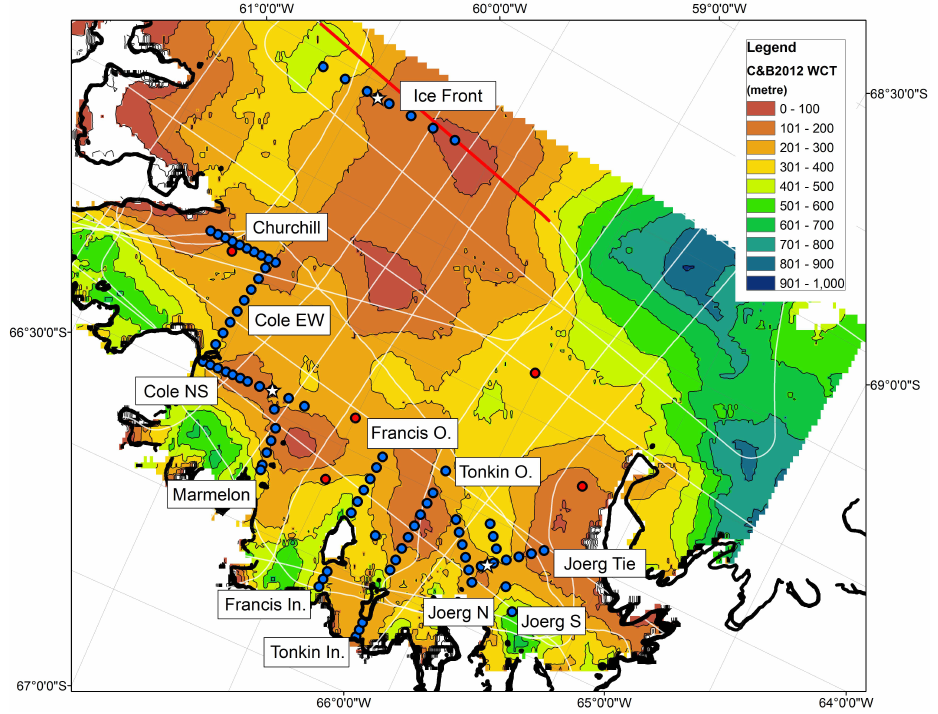
Fig. 2. Seismic reflection acquisition sites presented in Fig. 6 (blue circles) with line names as referred to in the text overlain on the contoured water cavity thickness derived from the inversion of IceBridge free-air gravity anomaly (Cochran and Bell, 2012). White stars indicate the three shallow seismic refraction sites where velocity-depth profiles were derived. Previous sites as per Fig. 1 (red circles). The grounding line as derived from DInSAR data (Rignot et al., 2011) is represented by the thick black coastline. The IceBridge flight line segment towards the ice front referred to in the text is indicated by the red line, all other IceBridge flight lines are in white (an edited version of which was used in the FAA